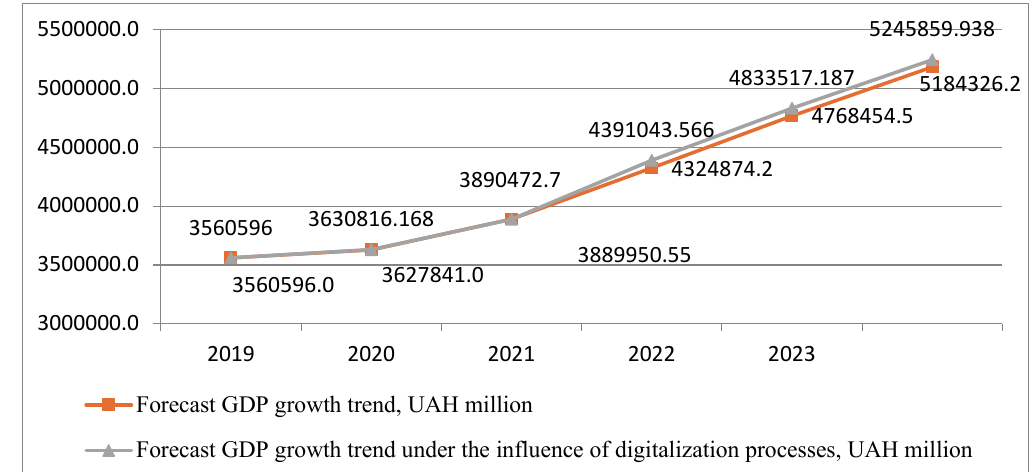
Fig. 4. Forecast extrapolation trend of production (services) growth in the information sector of Ukraine Source: calculated by the authors